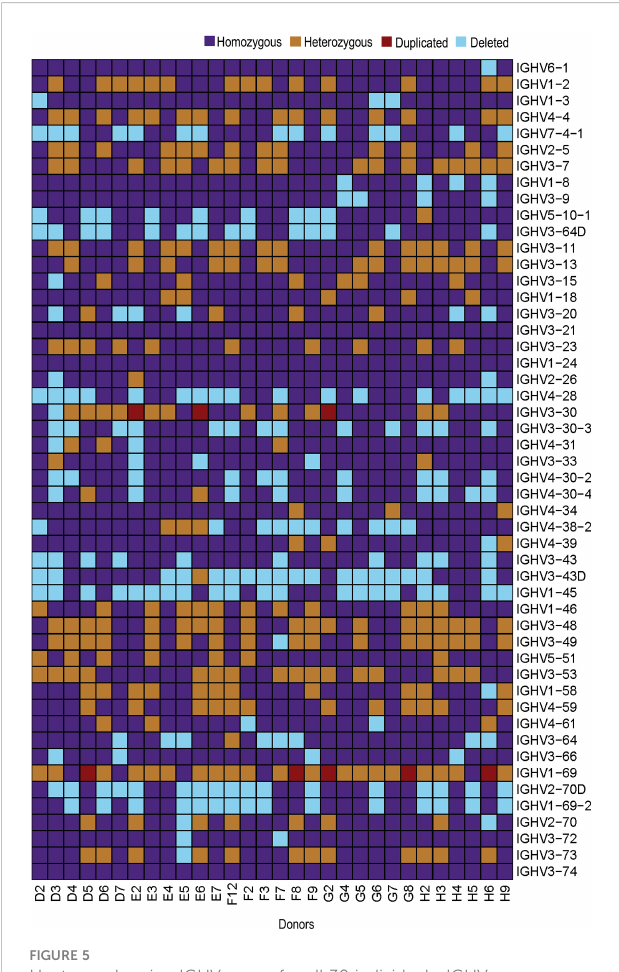
FIGURE 5 Heatmap showing IGHV genes for all 30 individuals. IGHV genes are represented on y-axis in chromosomal order with color-key on the